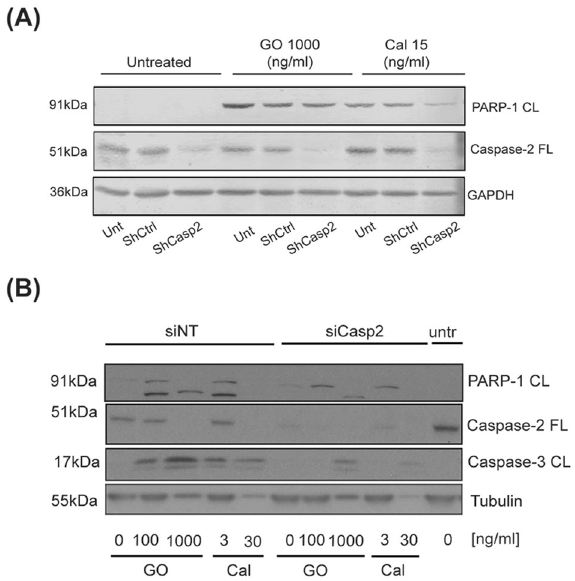
Fig. 4 Inhibition of caspase-2 protein expression blocks caspase-3 activity and PARP-1 cleavage after GO-treatment. THP-1 AML cells were stable transduced with shRNA targeting caspase-2 (shCasp2) or empty vector (shCtrl) ( A ) or transiently transfected with siRNA targeting caspase-2 (siCasp2) or a non-targeting control sequence (siNT) ( B ). Cells were thereafter treated with either GO 100 ng/ml or 1000 ng/ml or calicheamicin 3 ng/ml, 15 ng/ml, or 30 ng/ml for 24 h ( A ) or 40 h ( B ). Full-length caspase-2, cleaved caspase-3, and cleaved PARP-1 protein expression were analysed by immunoblotting. α - Tubulin was used as loading control.